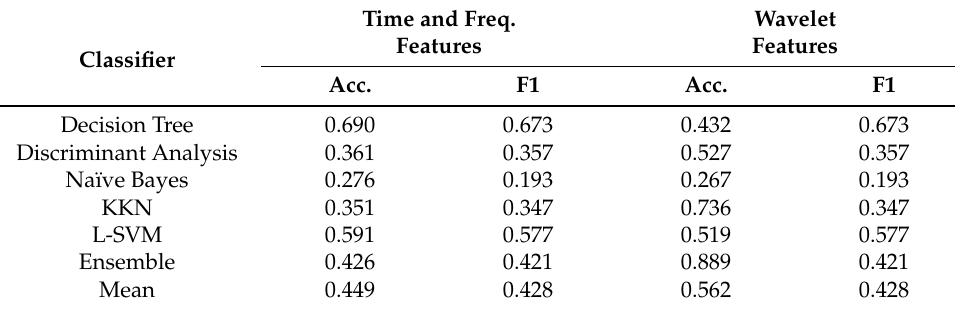
Table 2. Classifier screening, classifying in two dimensions.